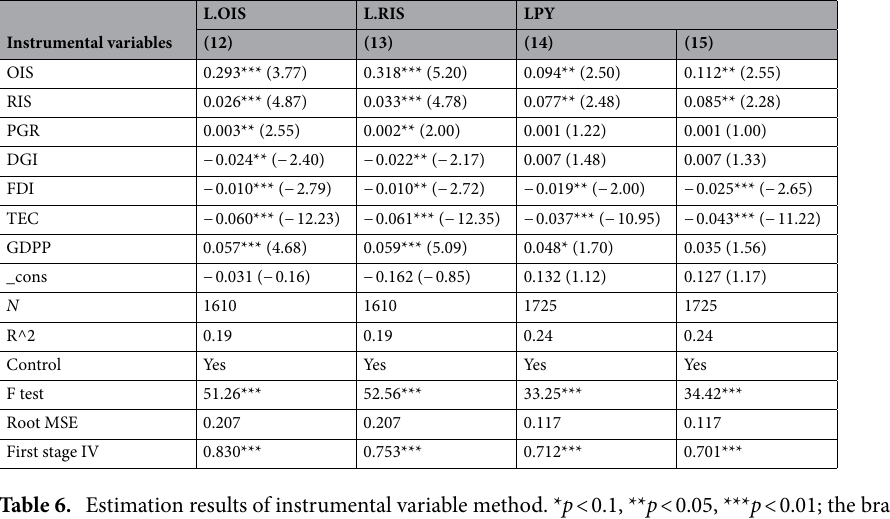
Table 6. Estimation results of instrumental variable method. * p < 0.1, ** p < 0.05, *** p < 0.01; the bracket represents the t